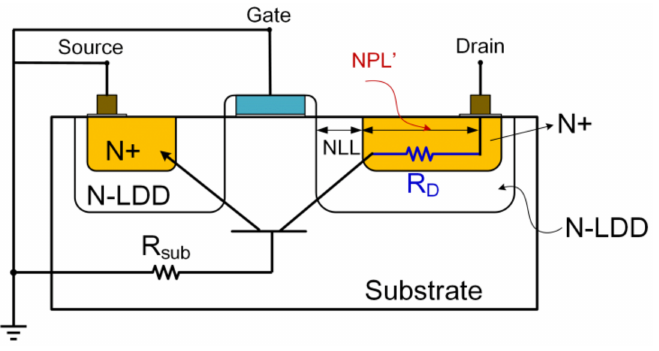
Figure 11. Cross-section of HV NMOS with extended N+ length.